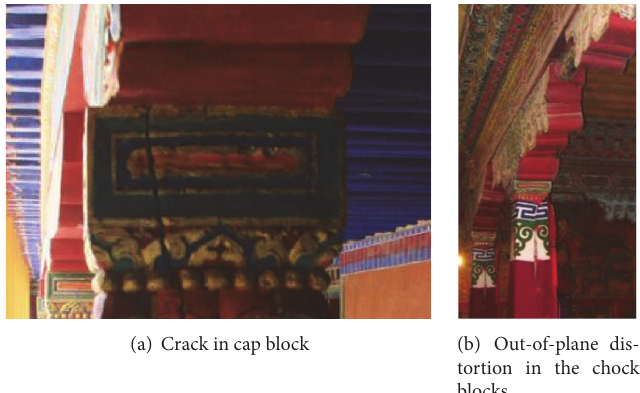
Figure 18: Damage of cap block and chock block.